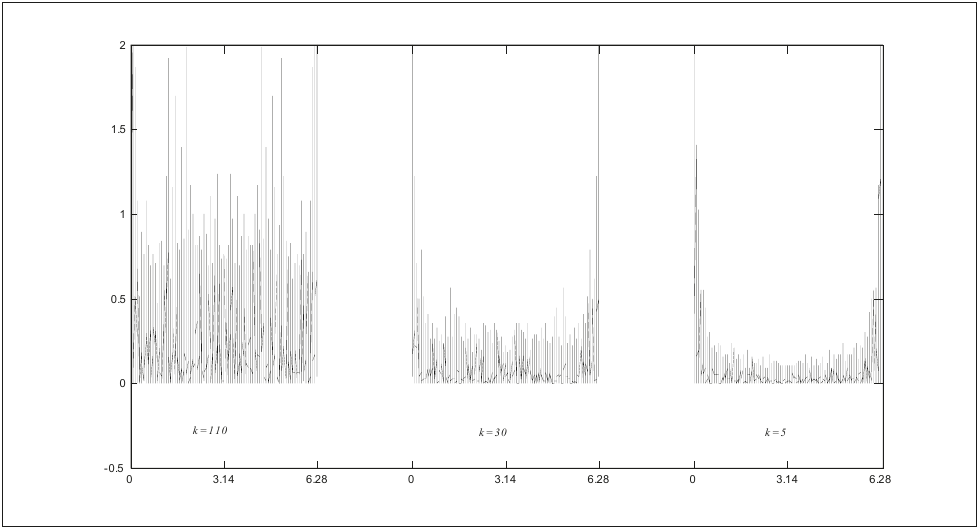
Figure 5. The periodogram of the log realized volatility obtained from 110-min returns ( left ), 30-min returns ( middle ), and 5-min returns ( right ) for the high-frequency S&P 500 returns data. The sample period is from 7 October 1986 to 2 March 2007.